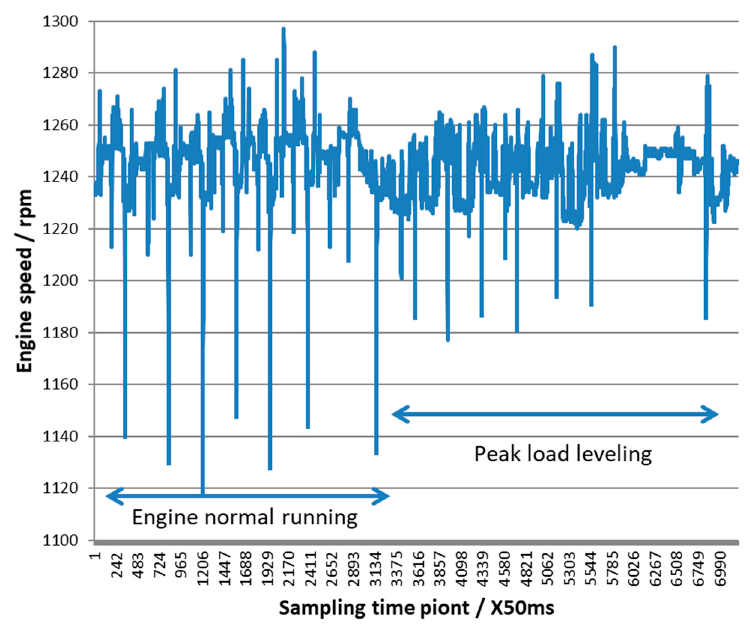
Figure 15. The engine speed in a comparison test.